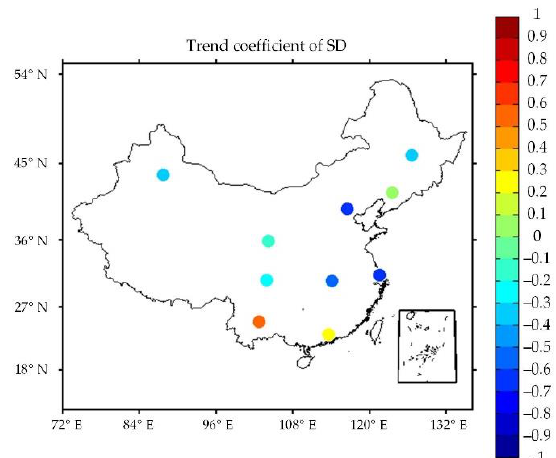
Figure 2. Trend coefficients of SD from 1981 to 2020 for the ten selected stations.